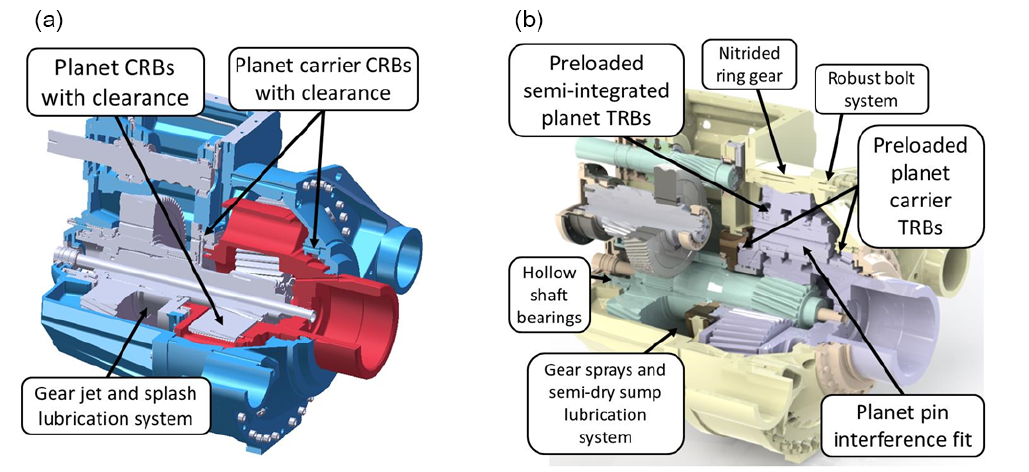
Figure 2. Comparison of the GRC gearbox designs featuring CRBs (a) and TRBs (b) . Illustration by Romax Technology (b) .